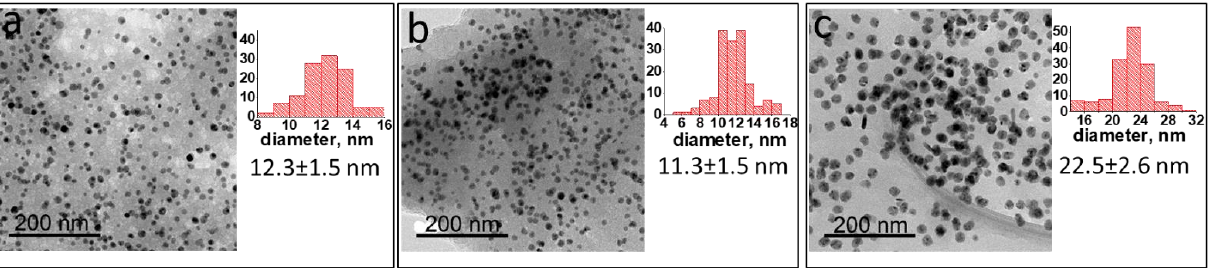
Figure 2. TEM images and size distributions of Ni NPs@PPP prepared by the heat-up approach at Ni(acac) 2 /PPP ratio = 0.5 mmol/0.148 g, for 30 min at 220 °C ( a ) and 280 °C ( b ) and Ni(acac) 2 /PPP = 0.5 mmol/0.0206 g for 30 min at 220 °C ( c ).